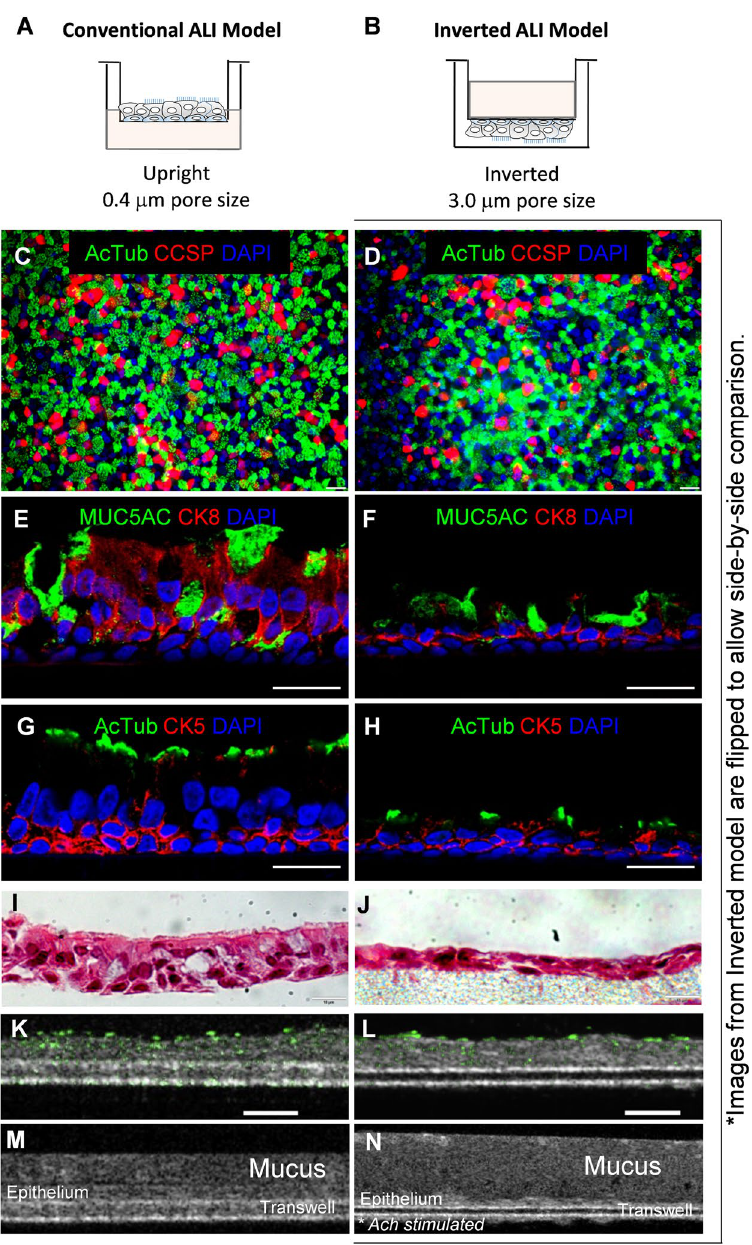
Figure 1. Establishment and characterization of inverted air-liquid interface (ALI) culture system compatible with the study of neutrophil transepithelial migration. In the conventional ALI model ( A ), human airway basal cells are seeded on the top of 0.4 µ m pore sized transwell membrane. The medium is added in the lower chamber to initiate and maintain air-liquid interface for the mucociliary differentiation. In inverted ALI model ( B ) for neutrophil migration study, human airway basal cells are seeded on the reverse side of 3 µ m pore sized transwell membrane. The medium is added to the upper chamber to initiate and maintain air-liquid interface for the mucociliary differentiation (see Method Section for the detailed description). For comparative purposes, images are oriented with the epithelial layer above the plane of the transwell filter. Conventional ( C ) and inverted ( D ) ALI transwells were wholemount stained for AcTub + ciliated cells, CCSP + Club cells, and DAPI + nuclei. Scale bar, 25 µ m. Conventional ( E , G ) and inverted ( F , H ) transwells were immunostained for differentiation marker CK8, goblet cell marker MUC5AC, ciliated cells marker acetylated tubulin (AcTub) and stem cell marker CK5 in transverse sections of ALI transwell membranes. Scale bar, 20 µ m. H&E staining also was used to display pseudostratified epithelium in the conventional ( I ) and inverted ( J ) models. µ OCT images of washed human airway basal cell-derived epithelium in conventional ( K ) and inverted ( L ) orientations with a thresholded map of intensity variation over time overlaid in green to accentuate beating cilia, scale bar 50 µ m. µ OCT analysis of an unwashed human airway basal cell-derived epithelium with mucus intact in conventional ( M ) and inverted ( N ) orientations. Images were analyzed at 3 different areas in > 3 separate experiments. Representative images are